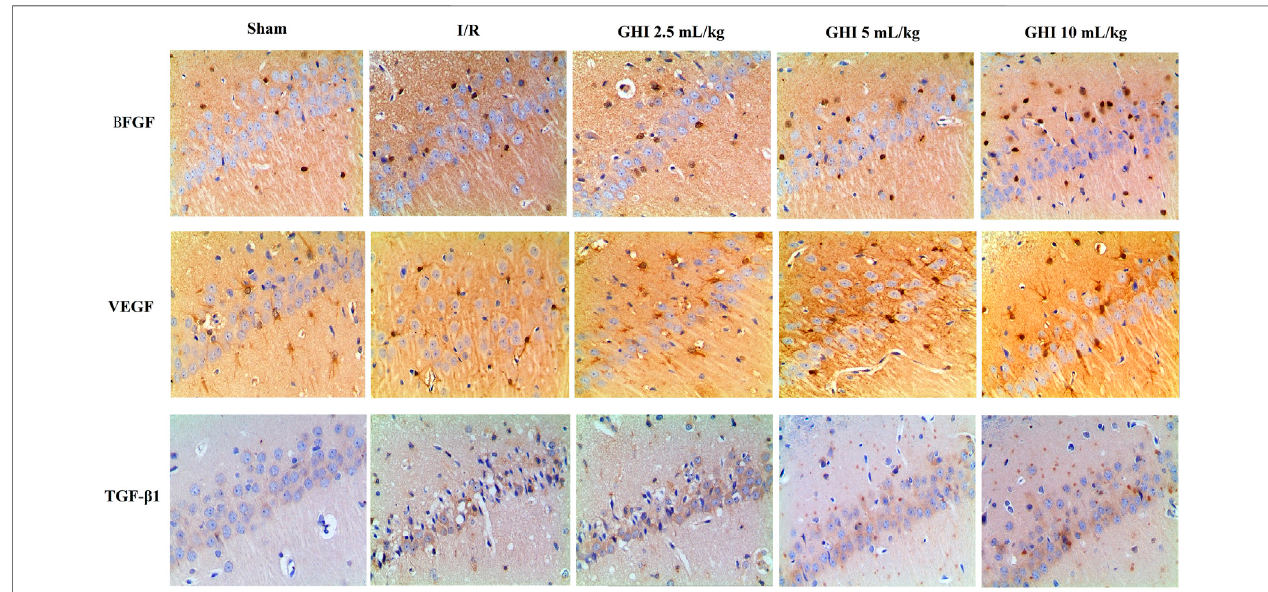
FIGURE 5 | Expressions of BFGF, VEGF, and TGF- β 1 immunostained tissue of focal cerebral I/R rats (magni fi cation 200 × ). Groups were as follows: Sham group (Sham), ischemia-reperfusion group (I/R group), GHI 2.5 ml/kg group, GHI 5 ml/kg group, and GHI 10 ml/kg group.